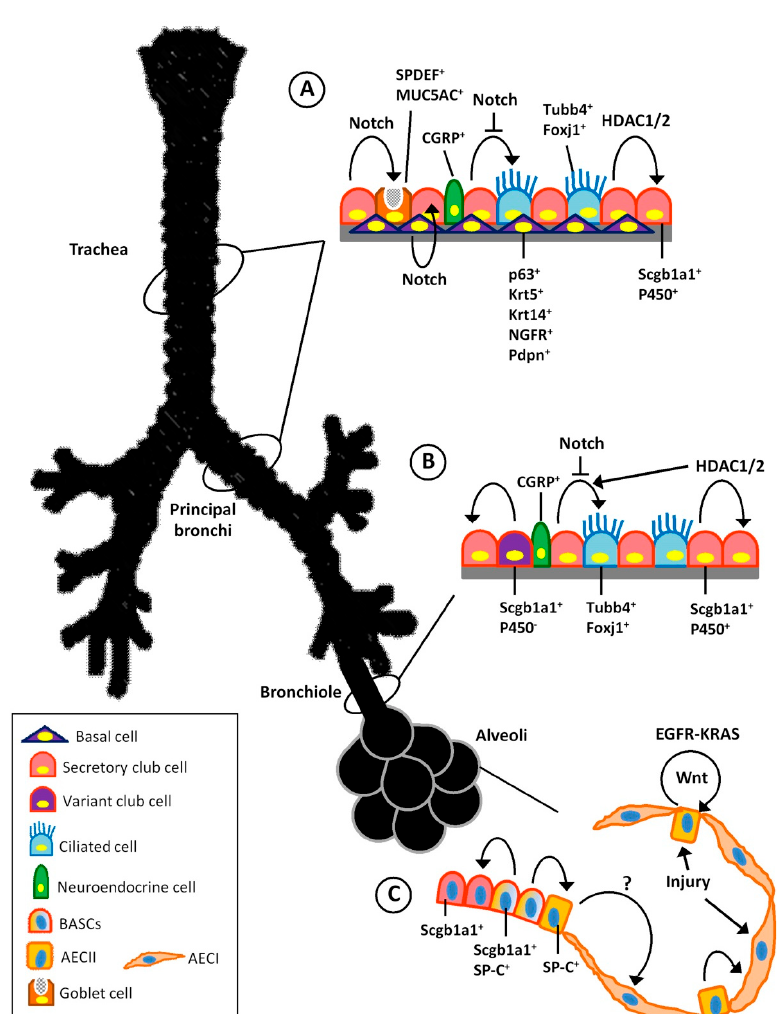
Figure 2. Endogenous stem cells in the airways and alveoli with their differentiation in the postnatal lung. ( A ) The trachea and bronchi of the rodent and human lung are lined with multiple epithelial lineages. Basal cells are located in this region and can generate secretory club and ciliated cell lineages. Notch signalling is crucial for differentiation of basal cells and also suppresses ciliated cell differentiation. HDAC1 and HDAC2 are essential for secretory epithelial regeneration; ( B ) The bronchiolar lining epithelium of rodents lacks basal cells but contains variant club cells, secretory cells and ciliated cells; ( C ) Progenitor cell populations and their differentiated progeny in the lung alveolus. The alveolar epithelium consists of alveolar epithelial cell AECI and AECII cells. AECII cells can generate AECI cells during homeostasis and after injury. Generation of alveolar epithelium by other cells, such as BASCs has yet to be supported by lineage tracing. The AECII to AECI differentiation signalling is not clear (marked by “?”), but AECII self-renewal and proliferation occurs via EGFR/KRAS signalling. Curved arrows indicate differentiation and line arrows indicate molecular or physical stimulus.